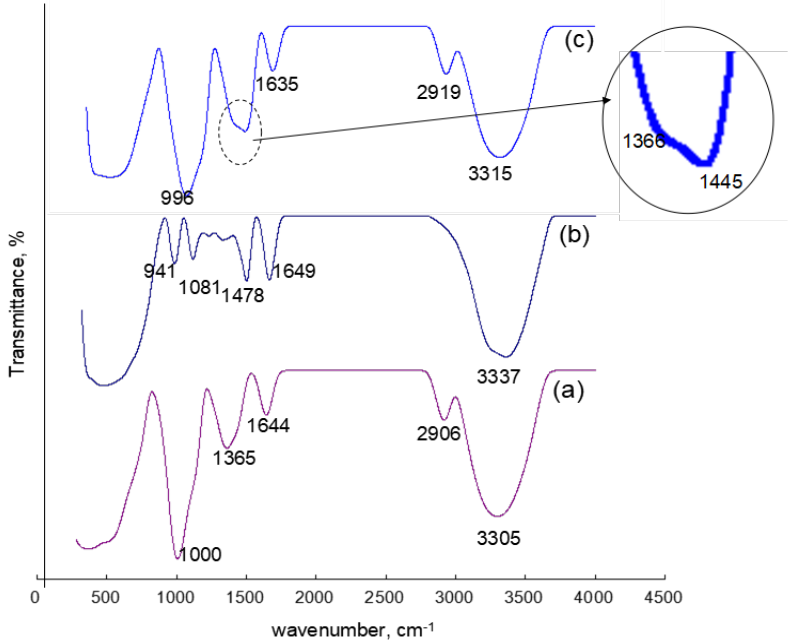
Figure 4. FTIR spectra for ( a ) sago starch, ( b ) CHPTAC, ( c ) cationic sago starch with DS = 1.195 at wave number 0–4000 cm − 1.